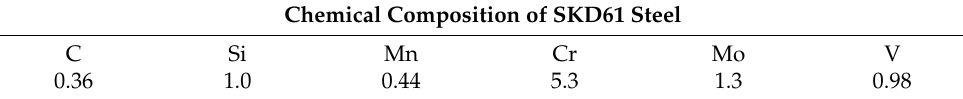
Table 3. Chemical composition of the SKD61 steel.